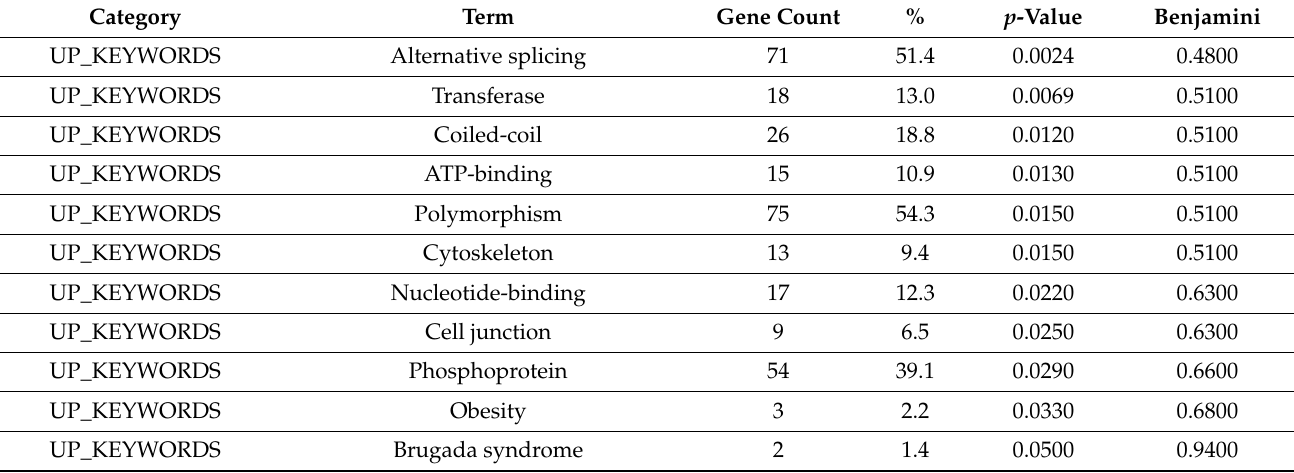
Table 4. UP_keywords functional category analysis result ( p -value ≤